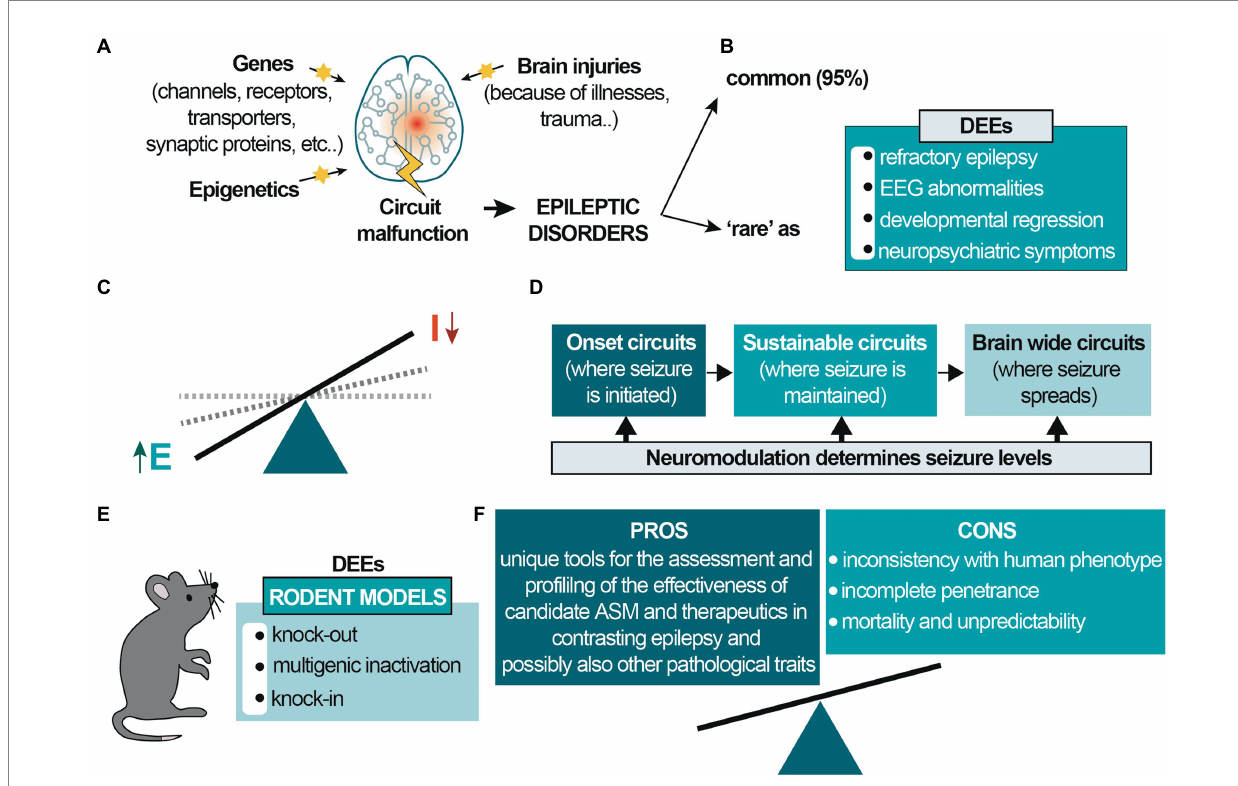
FIGURE 1 Etiology and circuit-based malfunctions in epilepsy. (A) Different genes, environmental/epigenetic factors and brain injuries may be the cause of circuit malfunctions that give rise to epilepsy, a network disease involving different interacting brain regions; (B) the prevalence of epileptic diseases is classified into common and rare epilepsies (~95 and ~5%, respectively). Developmental and epileptic encephalopathies (DEEs) are rare diseases mainly occurring in pediatric age. (C) In epileptic disorders the excitatory drive increases, generating hyperexcitability and E/I dysbalance; (D) epilepsy is initiated in different brain regions and activates synaptic brain circuits for seizure maintenance. It can further spread to other brain regions, generating comorbidities and increasing seizure severity. (E) Genetic rodent models for DEE mainly consist of knockout, multigenic deletions, and knock-in. These latter may be based on precise human point mutations, satisfying the criteria for ‘construct validity completely’; (F) Different pros and cons characterize these animal models. The most significant caveats concern the frequent inconsistencies with the human phenotype, particularly the possible absence of the epileptic phenotype and the incomplete penetrance of the mutation. The few models showing spontaneous epileptic seizures are often not viable or affected by a high mortality rate, and the seizures’ unpredictability makes them difficult to study. Despite this, genetic animal models are unique and valuable tools for assessing new candidate ASM and other therapeutic strategies and are necessary for subsequent clinical studies, thus benefits